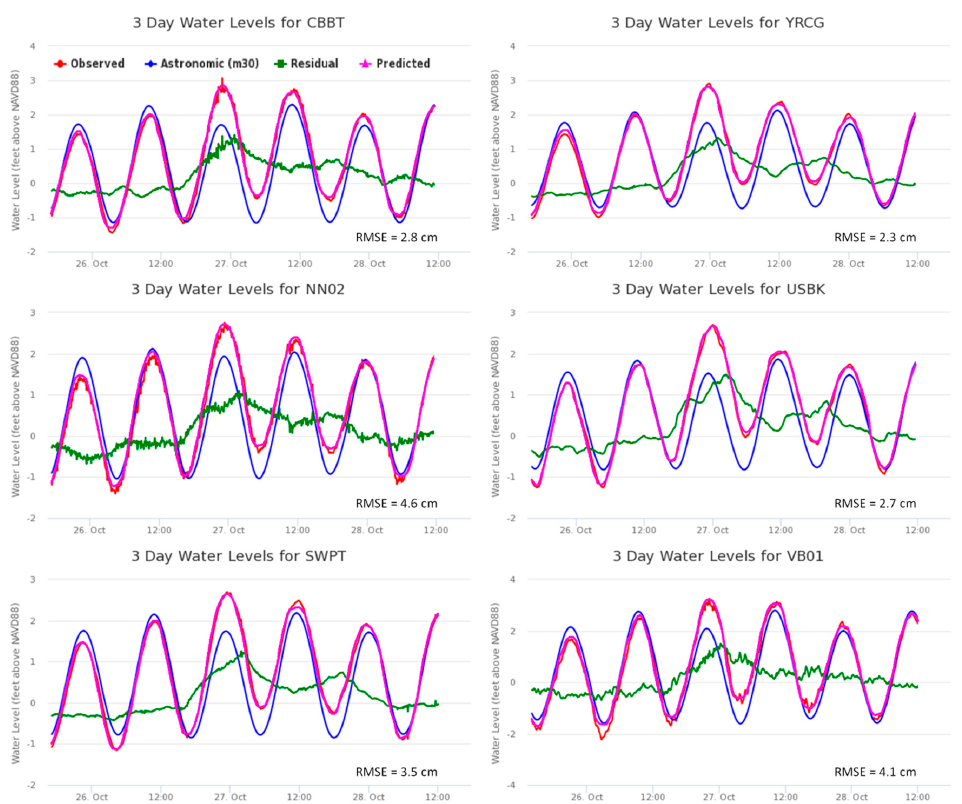
Figure 9. Time series of six Tidewatch Charts’ water level sensors’ observations (red), astronomical tidal estimations (blue), and computed residual difference (green), compared with SCHISM model predictions (pink) from Tidewatch Maps during Catch the King at 10:30 on 27 October 2018; UTC-5.